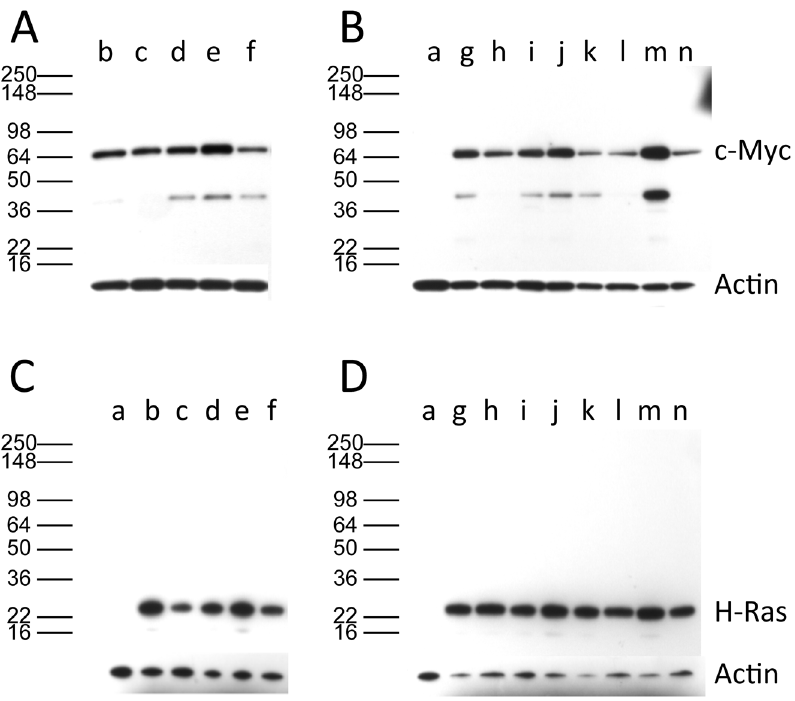
Figure 8. All tumor cell lines expressed both the H-Ras and the c-Myc proteins. Lysates of the tumor cell lines corresponding to 2.5 m g of protein for H-Ras detection and 30 m g of protein for c-Myc detection were resolved by SDS-PAGE on 4–20% gradient gels and the proteins revealed by western analysis. A & B : c-Myc. C & D : H-Ras. A & C : Lines from tumors induced by Sca I linear plasmid; B & D : Lines from tumors induced by Eco RI linear plasmid. Lanes a: NIH/3T3 mouse control cell line. Lanes b to n represent different tumor-cell lines; these lines correspond to the cell lines in